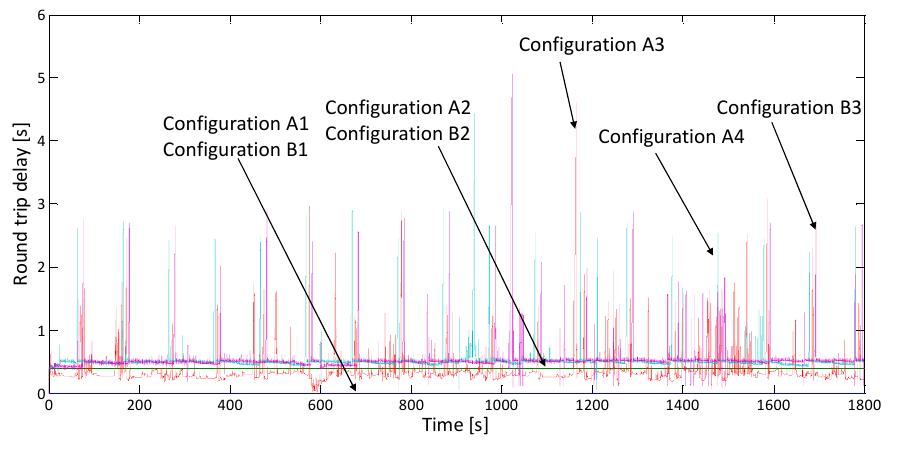
Figure 9. Roundtrip time under different configuration settings. Table 9. Roundtrip delay parameters.